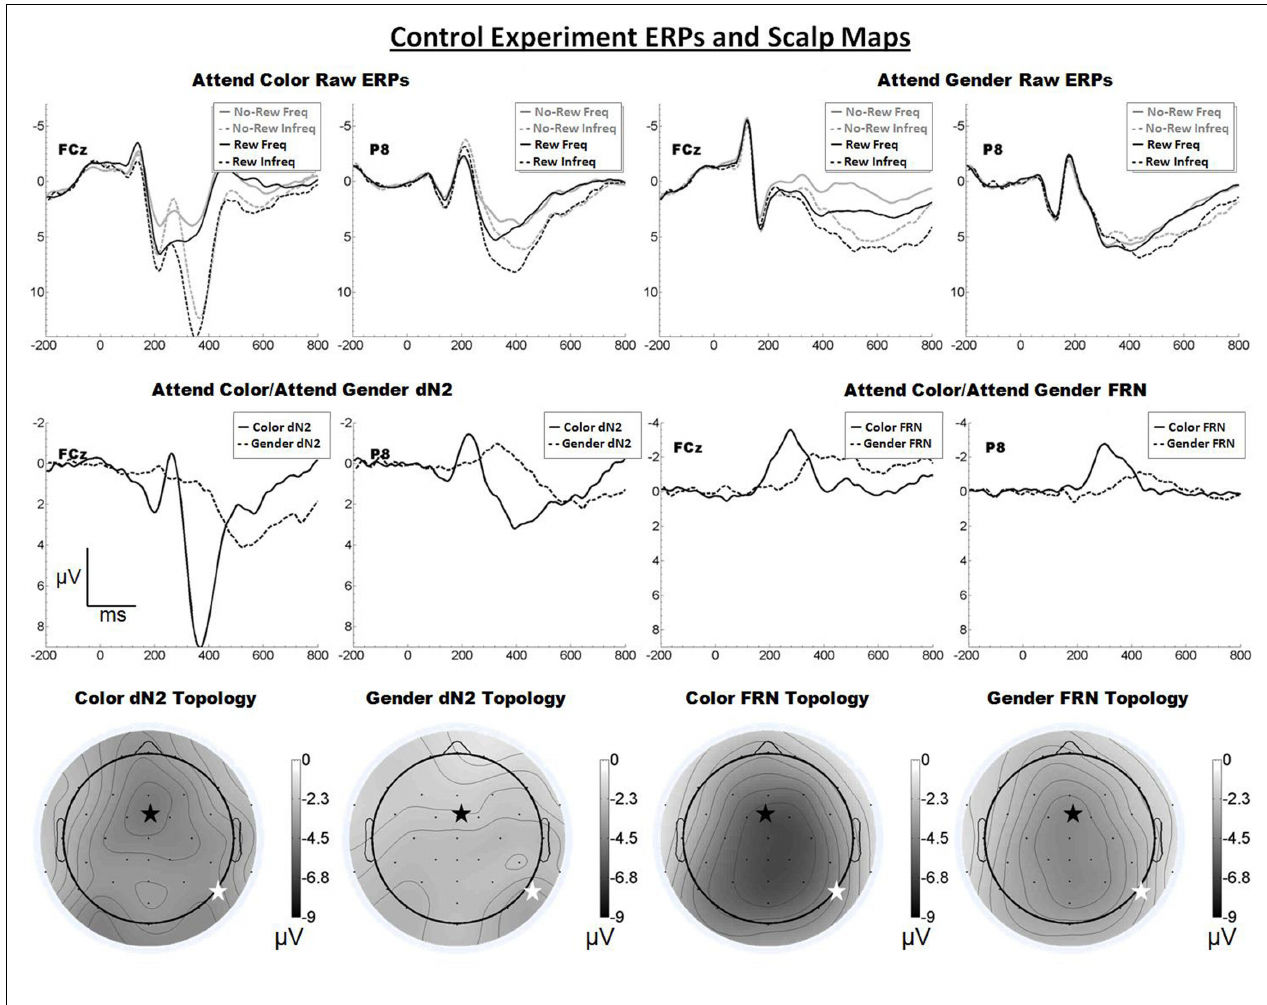
electrodes.The bottom row shows the scalp distributions of the dN2 and FRN across tasks.The scalp distributions reflect the base-to-peak measure of each of the dN2 and FRN.The black star on the scalp map denotes channel FCz, and the white star denotes P8. Note that negative is plotted